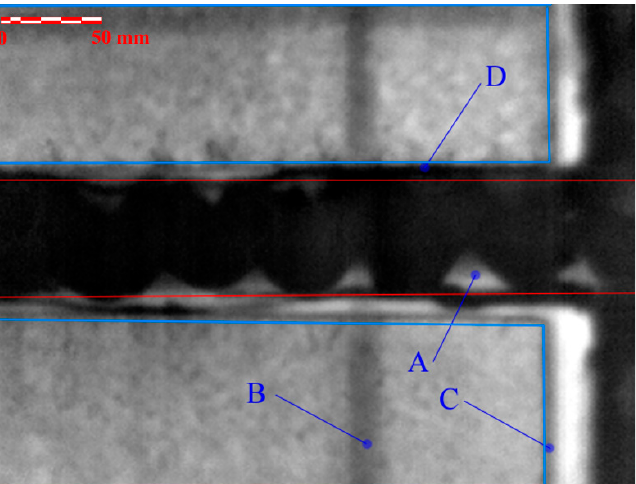
Figure 17. Results of the PT Nondestructive Evaluation (NDE) method: adhesive joint of the front wing spar and the wing tip rib on the lower wing side.